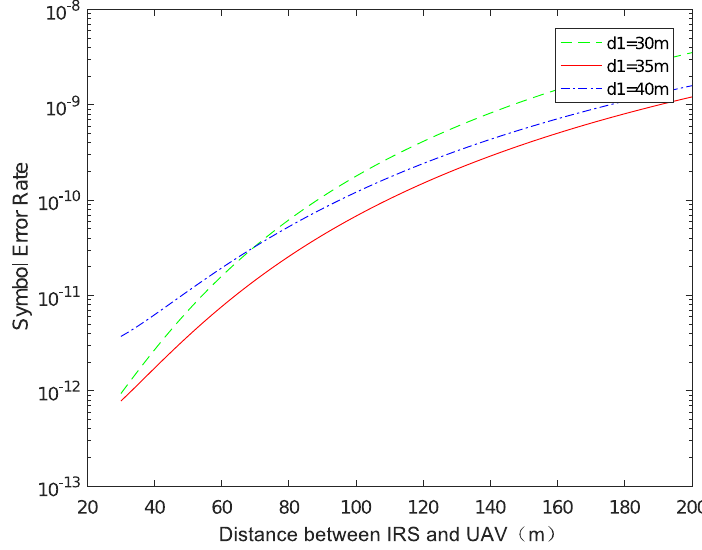
Figure 5. Symbol error rate versus d2 .